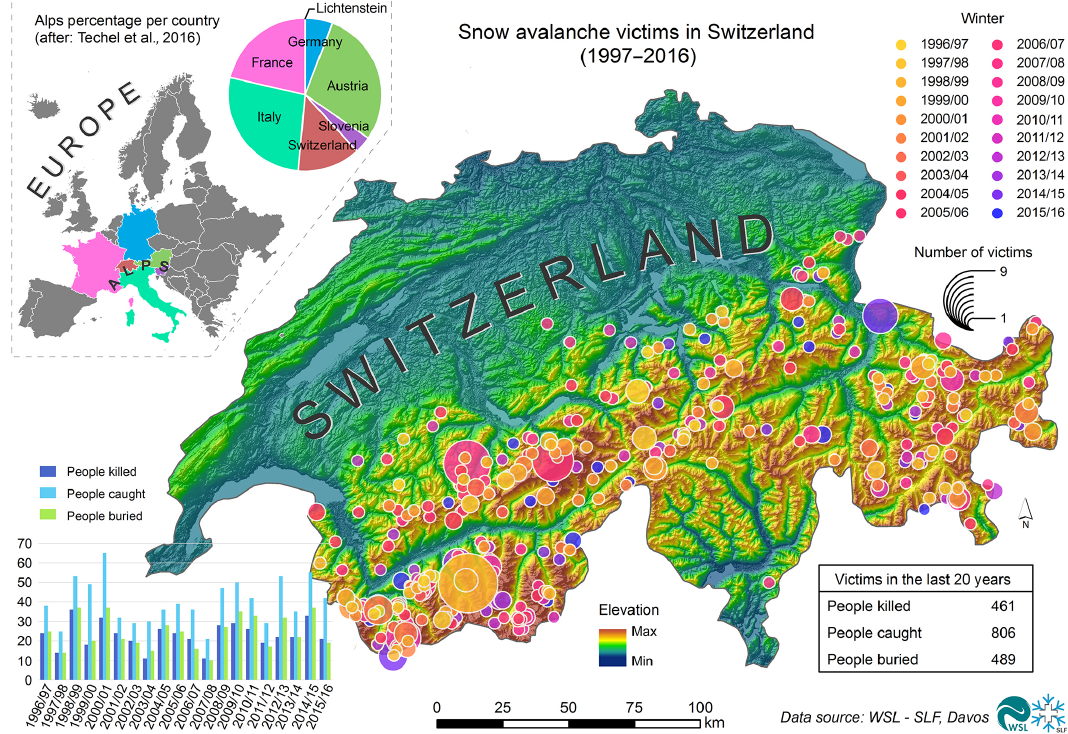
Figure 1. Snow-avalanche accidents with victims in Switzerland in the winters of 1996–1997 to 2015–2016 and the Alps percentage per country. People caught are those who had been caught by an avalanche but not totally buried. Data from WSL Institute for Snow and Avalanche Research SLF, Davos,